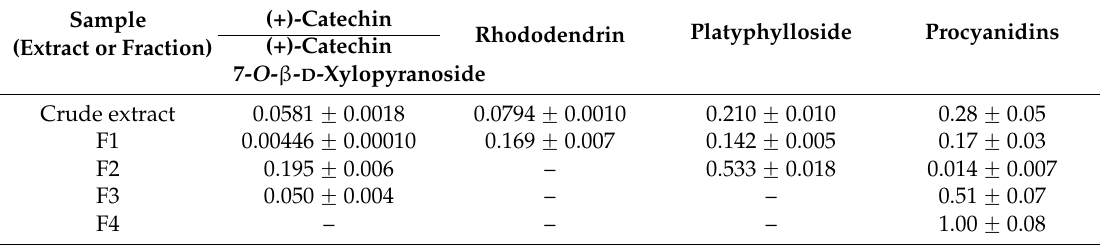
Table 3. Chemical compositions of the birch extract (NP1) and its fractions (coded F1–F4). The results are expressed as mg of compound/mg dry fraction or extract ˘ SD ( n = 6 for procyanidins and n = 3 for other